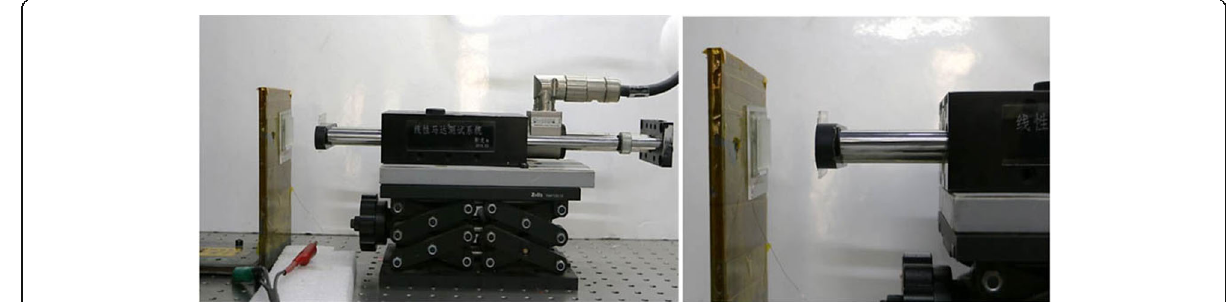
Fig. 3 Photograph of experiment setup applying external